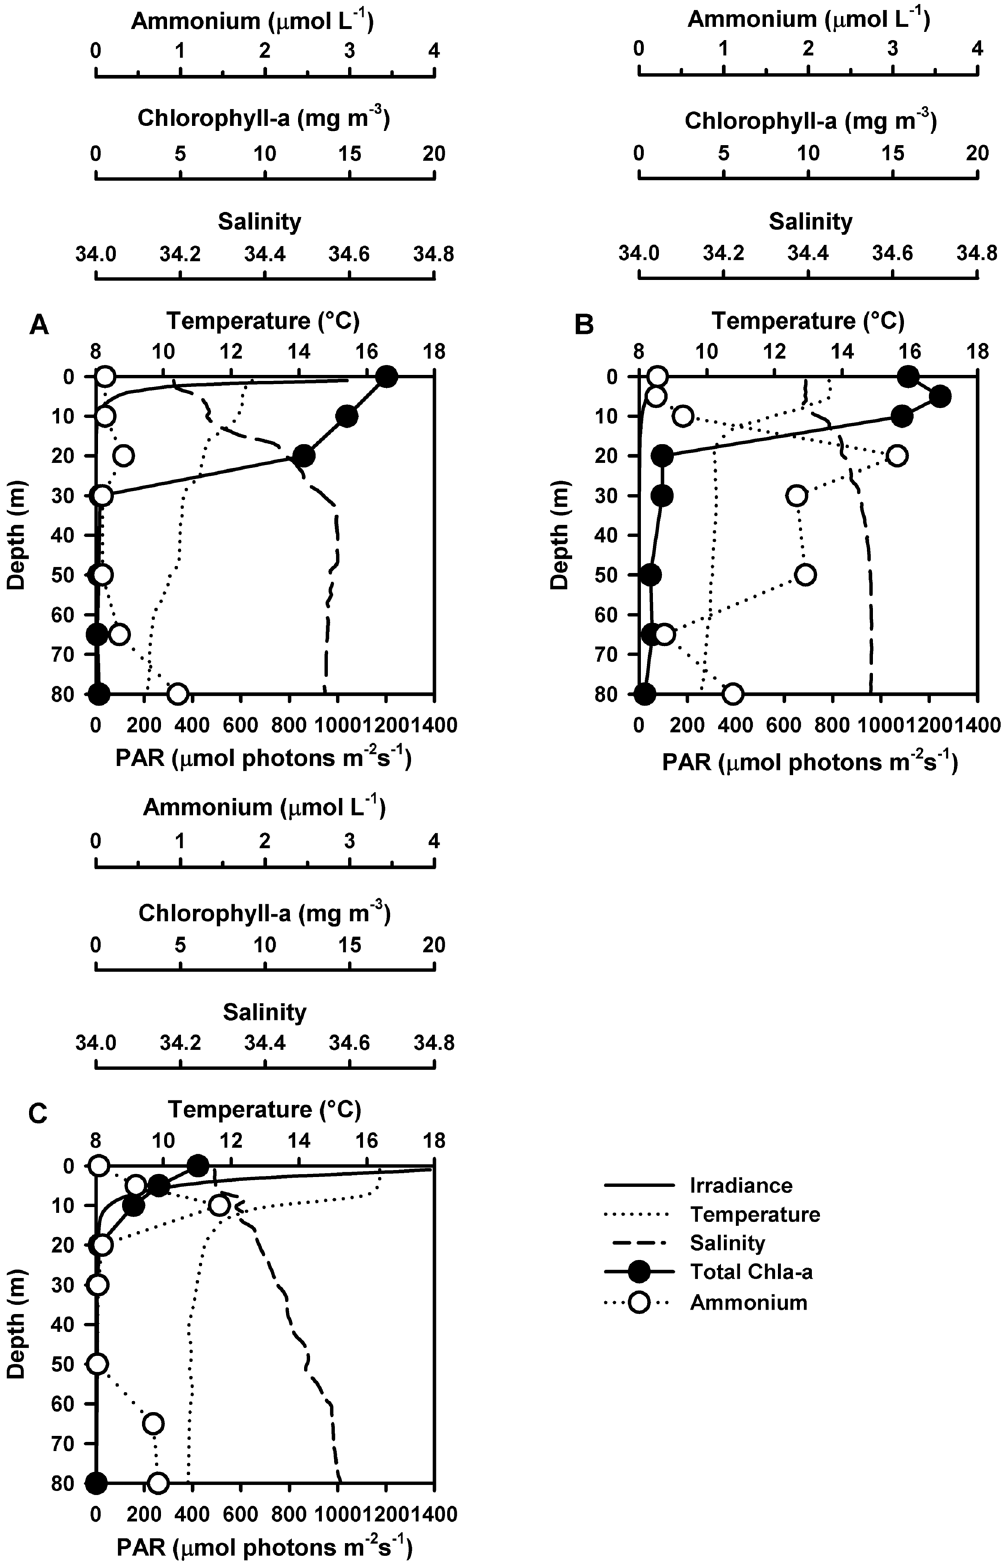
Figure 5. Hydrographic conditions of irradiance, salinity, temperature and ambient concentrations of total chlorophyll-a and ammonium during photoproduction experiments. Profiles were carried out in (A) September 2011, (B) November 2011 and (C) January 2012.